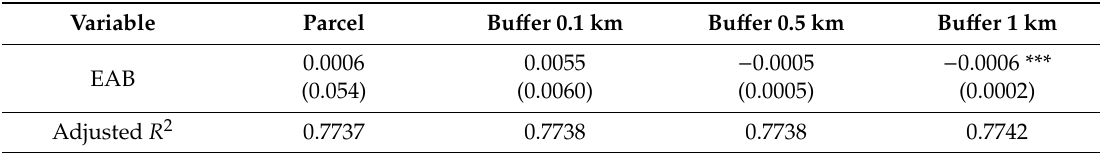
Table 4. Coe ffi cient Estimates of Hedonic Model 2, emerald ash borer (EAB) Detections, 2012–2015 ( n =